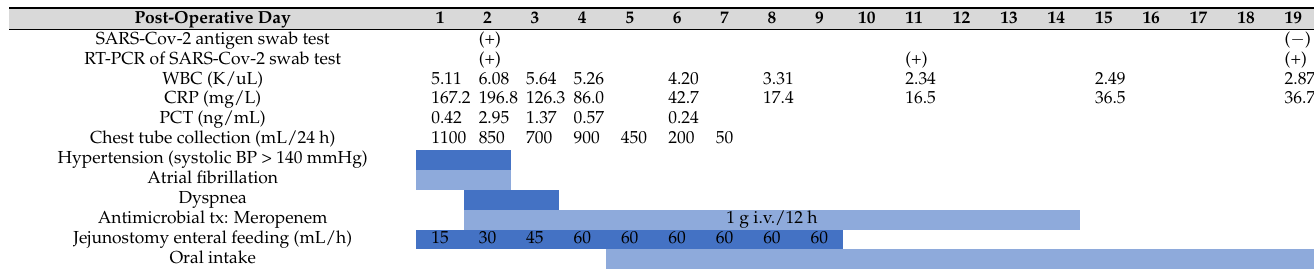
Table 1. Time course in terms of clinical laboratory results, symptoms, and interventions. RT-PCR, Reverse transcription polymerase chain reaction; WBC, white blood count; CRP, C-reactive protein serum level; PCT, procalcytonin serum level. The colors indicate the presence of a given parameter’.